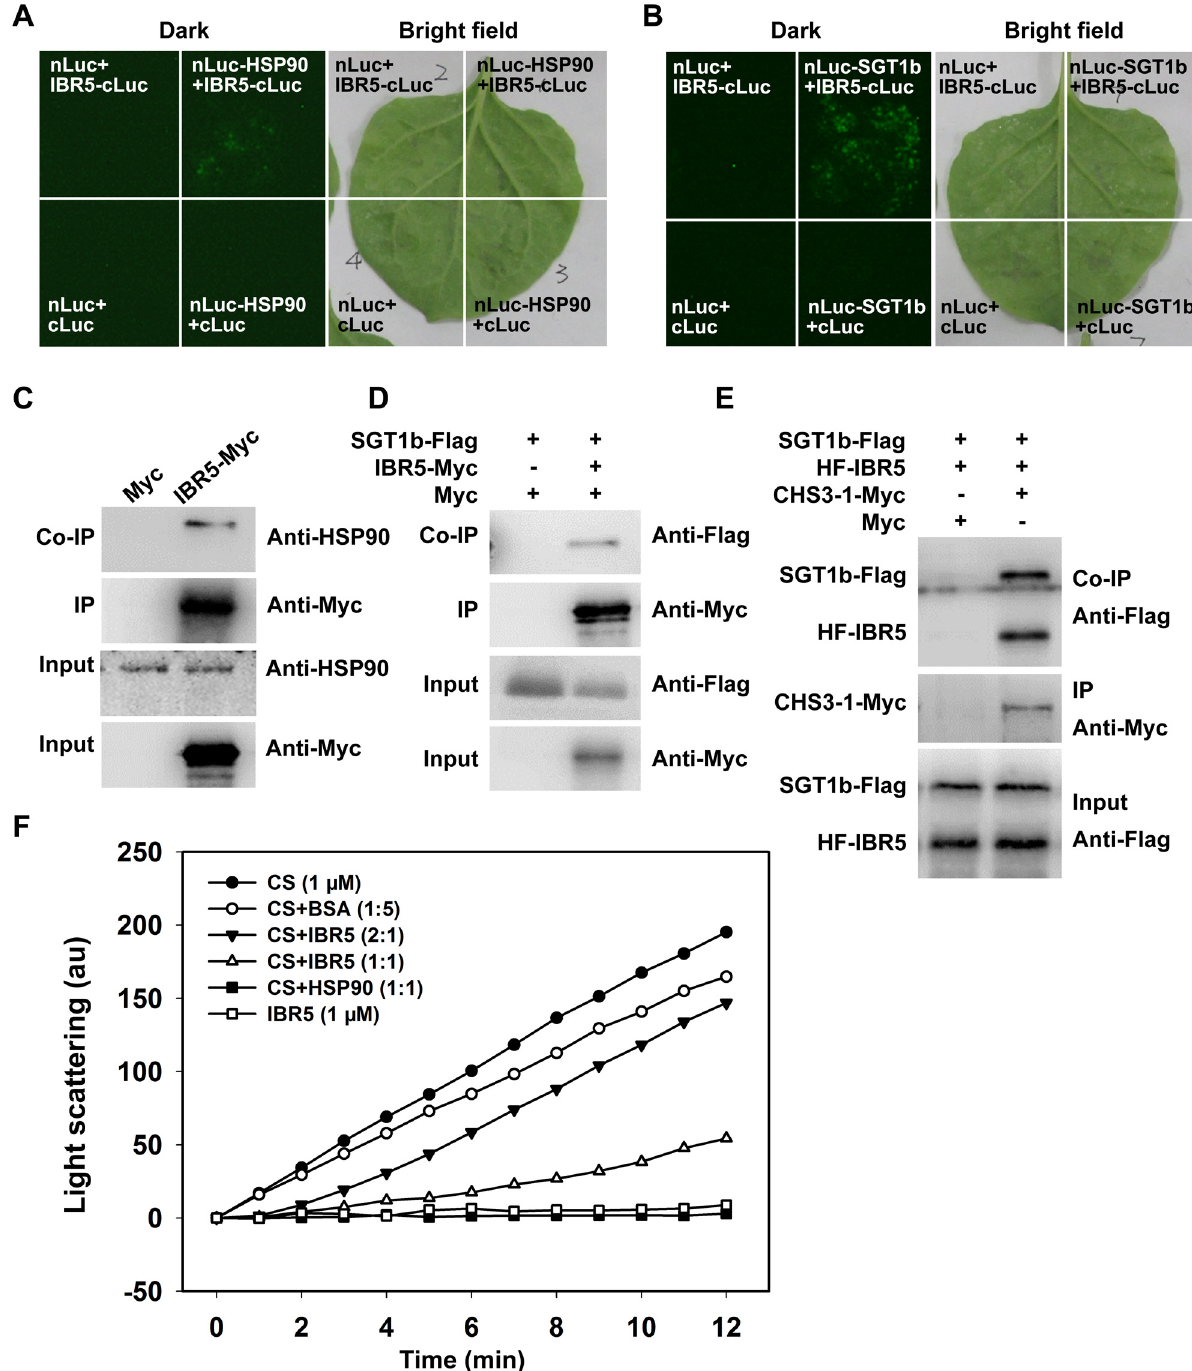
Fig 6. Interaction of IBR5 with HSP90 and SGT1b. (A) Interaction of IBR5 with HSP90 as revealed via firefly luciferase complementation imaging assay in N . benthamiana leaves. nLuc+cLuc-IBR5, HSP90-nLuc+cLuc, and nLuc+cLuc were used as negative controls. (B) Interaction of IBR5 with SGT1b as revealed by a firefly luciferase complementation imaging assay in N . benthamiana leaves. nLuc+cLuc-IBR5, SGT1b-nLuc+cLuc, and nLuc+cLuc were used as negative controls. (C) Co-immunoprecipitation of IBR5 and HSP90. Total protein was extracted from 2-week-old transgenic seedlings expressing Super : IBR5-Myc or Super : Myc . Anti-Myc antibody was used for immunoprecipitation, and the immunoprecipitated proteins were analyzed by immunoblotting using an anti-HSP90 antibody. (D) Co-immunoprecipitation of IBR5 and SGT1b. Total protein was extracted from transgenic plants expressing Super : Myc/Super : SGT1b-Flag or Super : IBR5-Myc/Super : SGT1b-Flag . An anti-Myc antibody was used for immunoprecipitation, and the immunoprecipitated proteins were analyzed by immunoblotting using an anti-Flag antibody. (E) Interaction of CHS3 with IBR5 and SGT1b in plant. Total proteins were extracted from N .